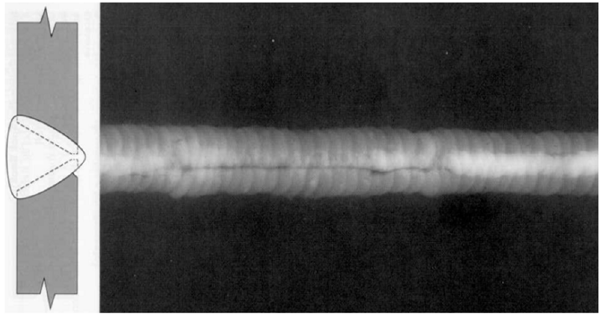
Figure 2. X-ray inspection of an undercut defect inside the weld.